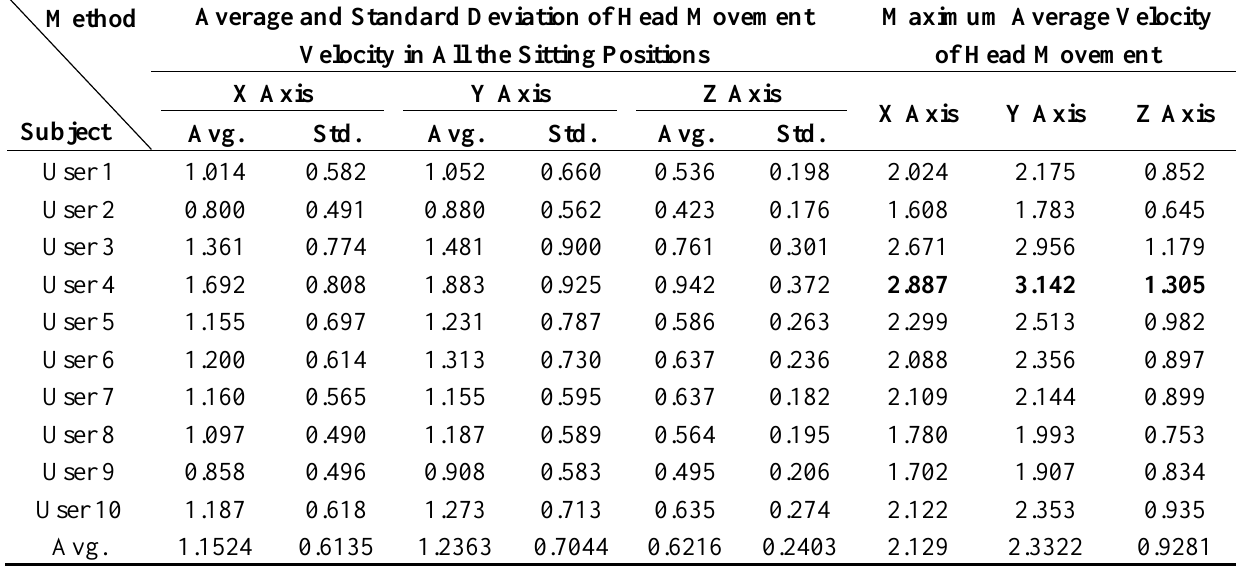
Table 2. Measured velocity of head movement of each subject (unit: